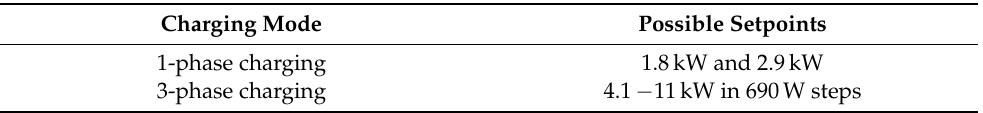
Table 5. Charging power setpoints for a grid voltage of 230V and the Smart e.d. of the wallbox (3-phase charging) and the emergency charging cable (1-phase